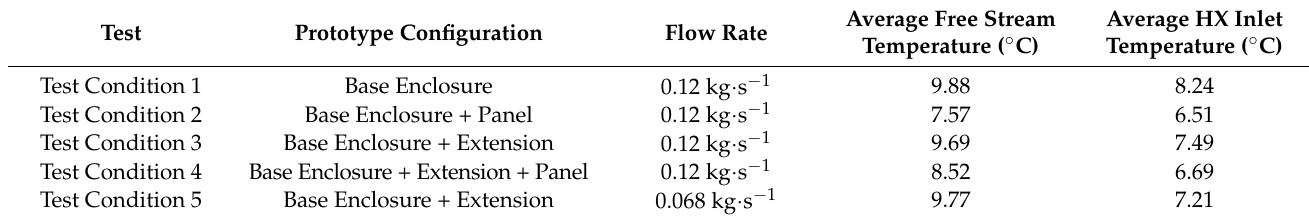
Table 1. Prototype configurations and test